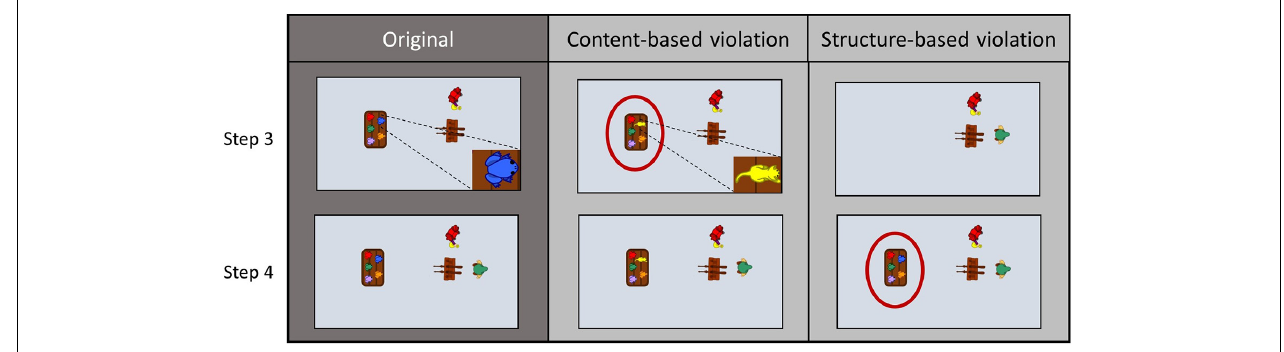
FIGURE 2 | Three different versions of two adjacent action steps for the story “shooting gallery”. Sample video frames of the original version (left column) show how a table with five different colored frogs is placed (step 3) before the fair visitor with the green hat enters the scene (step 4). In the content-based modification (middle column) the blue frog on the table is replaced by a yellow cat, while in the structure-based modification (right column) the table with the five different colored frogs is placed (step 4) only after the fair visitor entered the scene (step 3).